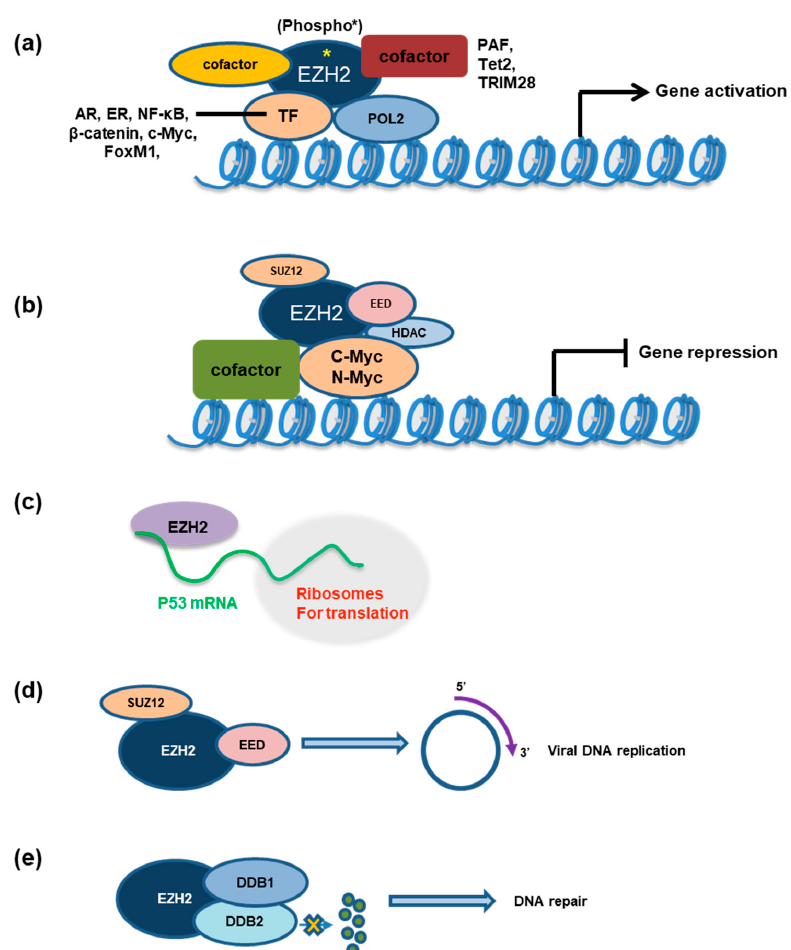
Figure 3. EZH2 establishes a range of canonical (in form of PRC2) and noncanonical